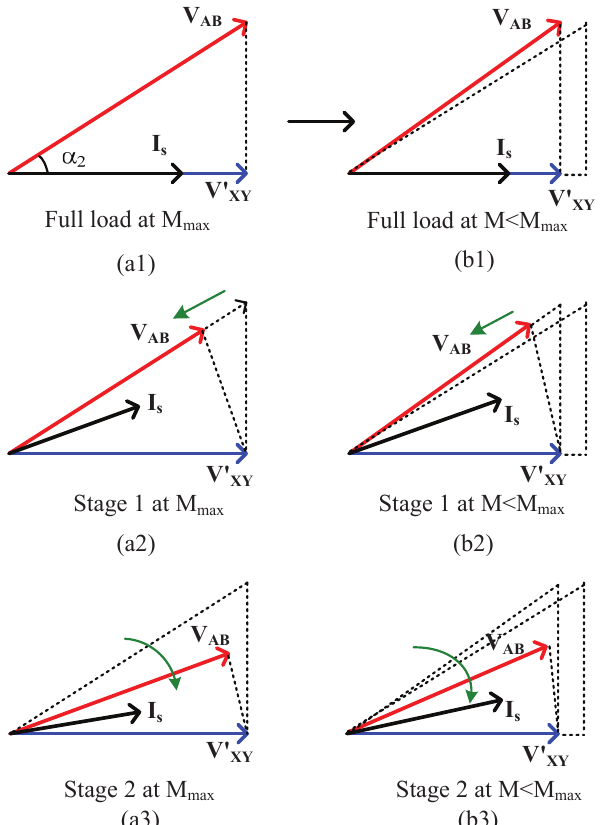
Figure 6. Phasor diagram of the DBSRC with the piecewise dual-phase-shift (PW-DPS) control strategy for positive power flow.